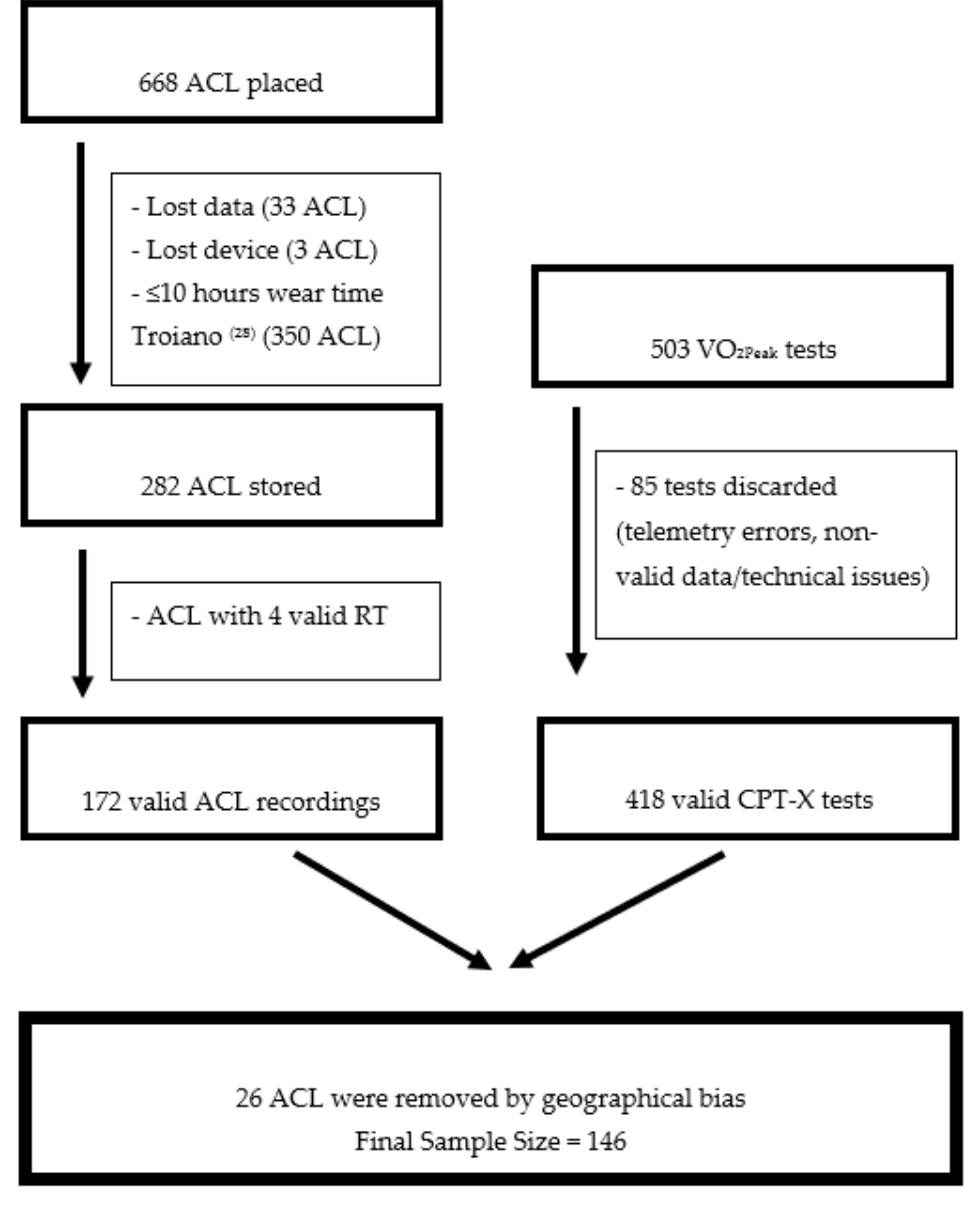
Figure 1. Flux diagram of inclusion criteria of the sample.